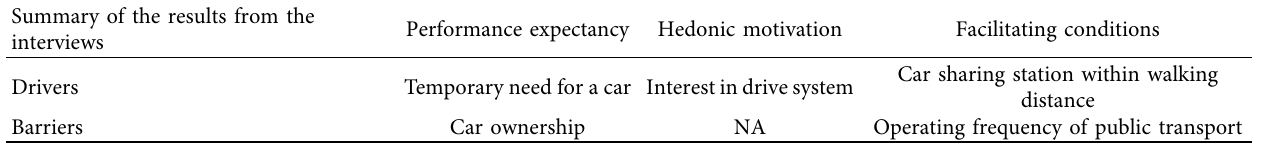
Table 4: Summary of the results from the